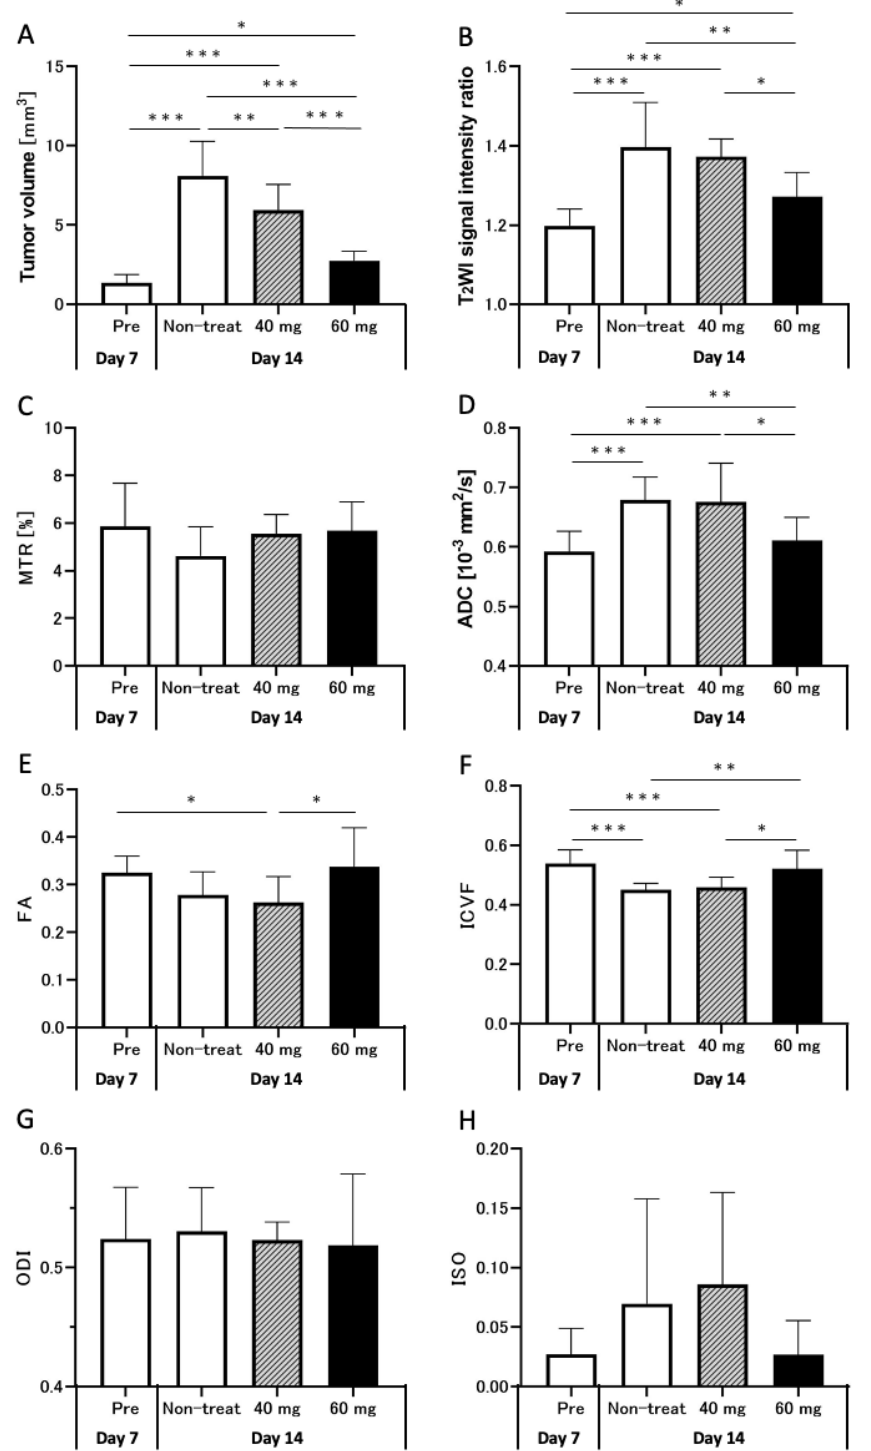
Figure 3. Graphs quantifying the tumor volume ( A ), T 2 WI signal intensity ratio ( B ), MTR ( C ), ADC ( D ), FA ( E ), ICVF ( F ), ODI ( G ), and ISO ( H ) in pre-treatment group on day 7 (white bars, n = 25) and non-treatment (white bars, n = 10), TMZ-40 mg (gray bars with diagonal lines, n = 7), and TMZ-60 mg (black bars, n = 8) groups on day 14 after transplantation. *: p < 0.05; **: p < 0.01; ***: p < 0.001; 40 mg, TMZ-40 mg; 60 mg, TMZ-60 mg; MTR, magnetization transfer ratio; ADC, apparent diffusion coefficient; FA, fractional anisotropy; ICVF, intracellular volume fraction; ODI, orientation dispersion index; ISO, isotropic volume